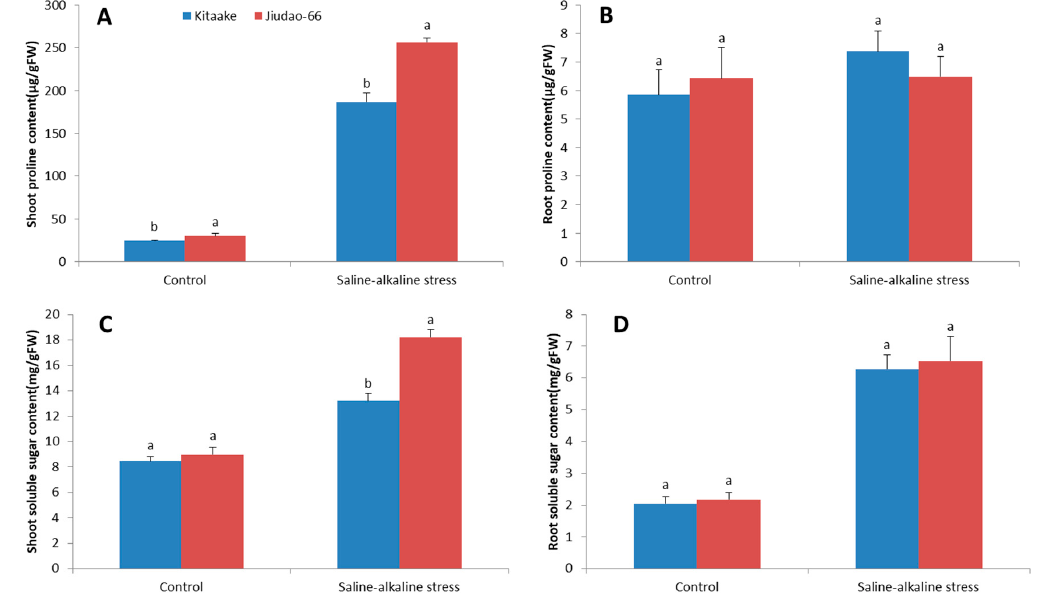
Figure 4. ( A , B ) Proline and ( C , D ) soluble sugar content of shoots and roots of Kitaake and Jiudao-66 seedlings grown in normal and saline–alkaline stress conditions. Treatments and statistical analyses were as described in Figure 2. Different letters (a, b) indicate significant differences at p < 0.05.